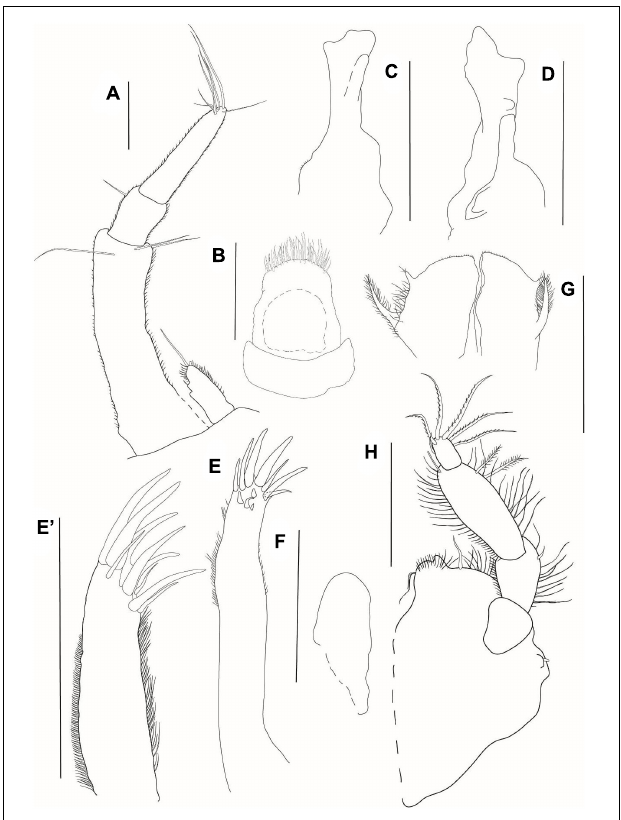
FIGURE 8 | Agathotanais jani n. sp., neuter, holotype ( A,B : ZMH-K-61149), juvenile male, paratype ( C,D : ZMH-K-61159). (A) Dorsal view; (B) lateral view; (C) dorsal view; (D) lateral view. Scale bar: (A–D) = 100 µ m.